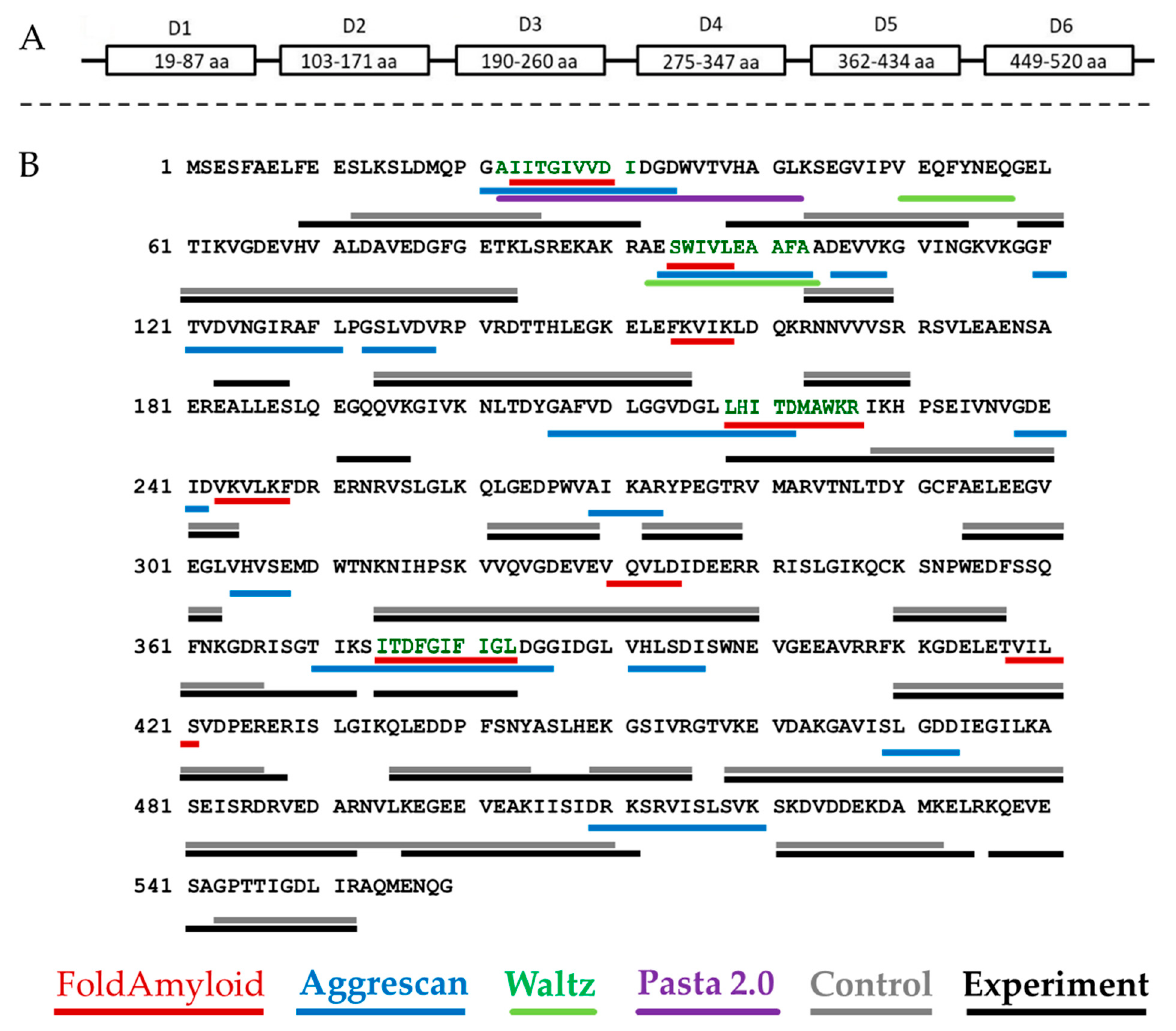
Figure 1. Schematic representation of the domain organization of bPaS1 ( A ) and comparison of predicting amyloidogenic regions using programs with the results of peptide coverage after LC-MS analysis of hydrolysates of control and experimental (aggregate) protein preparations ( B ). The peptides identified in the control and experimental samples, respectively, are underlined in gray and black. The bPaS1 sequence is taken from the UniProt database (UniProt. Available online: https://www.uniprot.org/uniprot/Q9HZ71 (accessed on 20 January 2021)). The regions of bPaS1, prototype peptide synthesis, are shown black–green color.